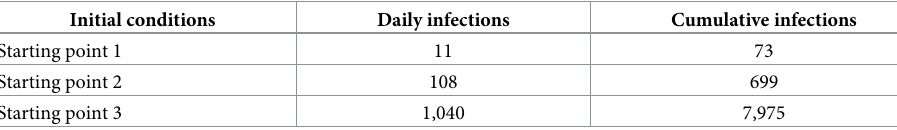
Table 2. Starting points of different random streams for facemask